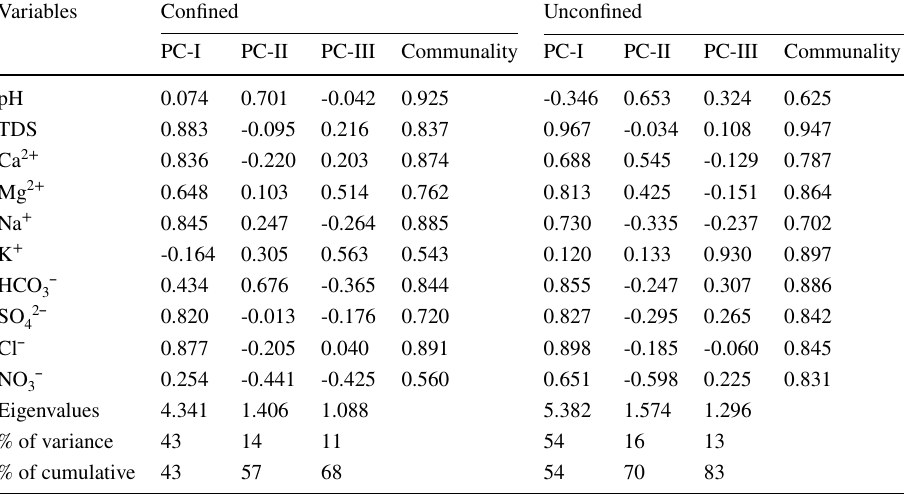
Table 8 Results of the principal component analysis (PCA) of groundwater parameters